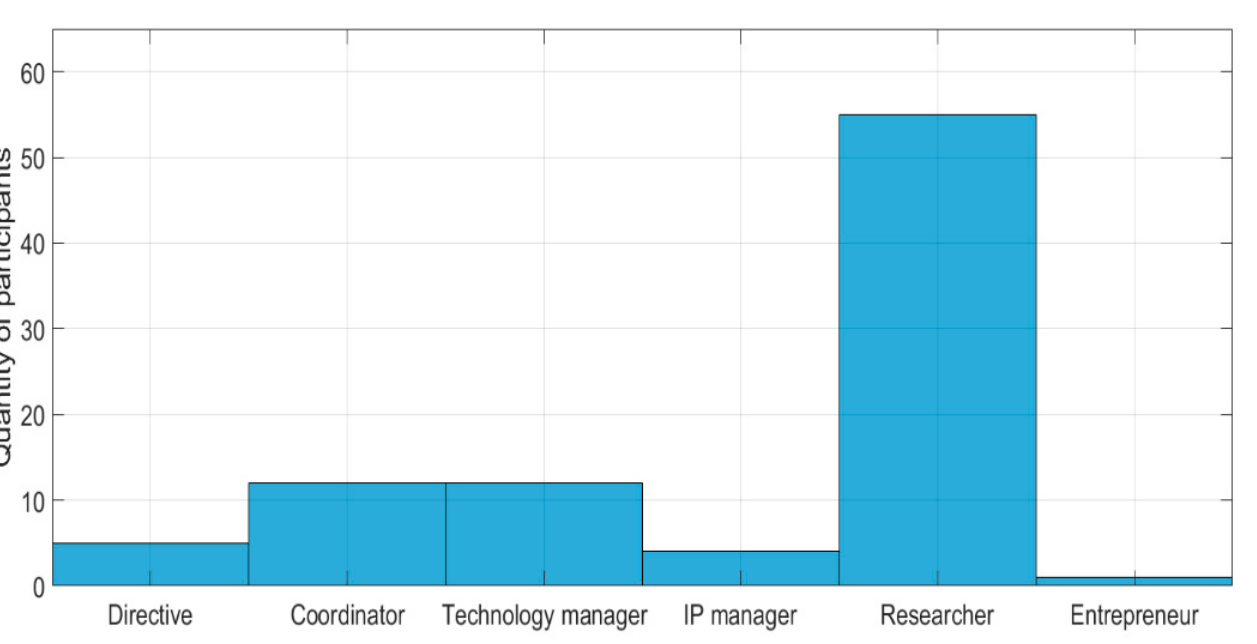
Table 2. Importance of the activities in the POVD; acronyms can be found in Sections 2.1 and